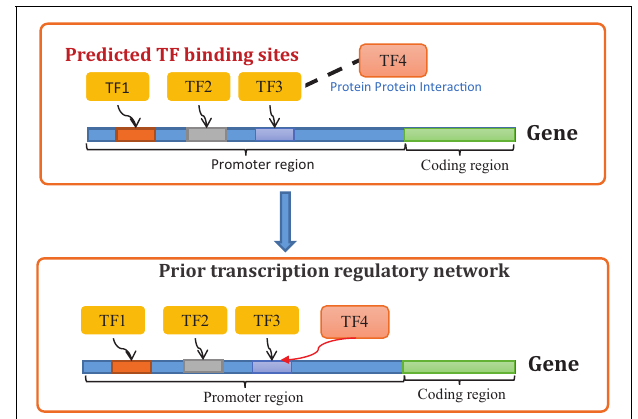
FIGURE 1 | Constructing prior transcription regulatory network using TFBS and PPI